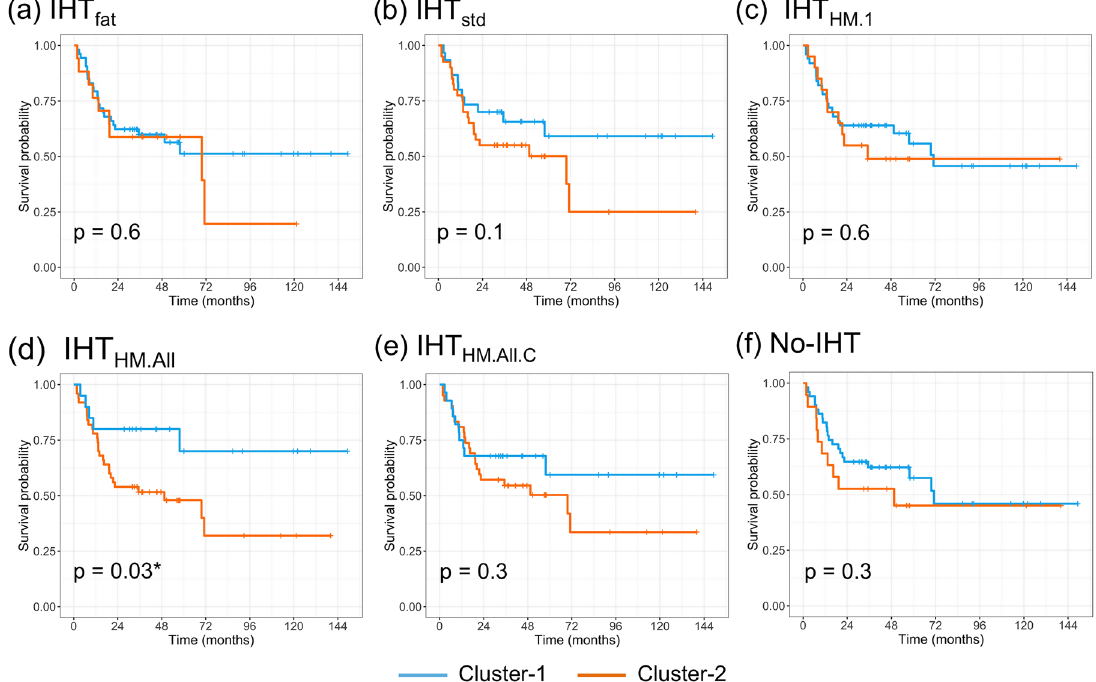
Figure 4. Kaplan–Meier curves for metastatic-relapse free survival depending on unsupervised clustering results based on radiomics features obtained with the different intensity harmonization techniques (IHT) or no use of harmonization technique